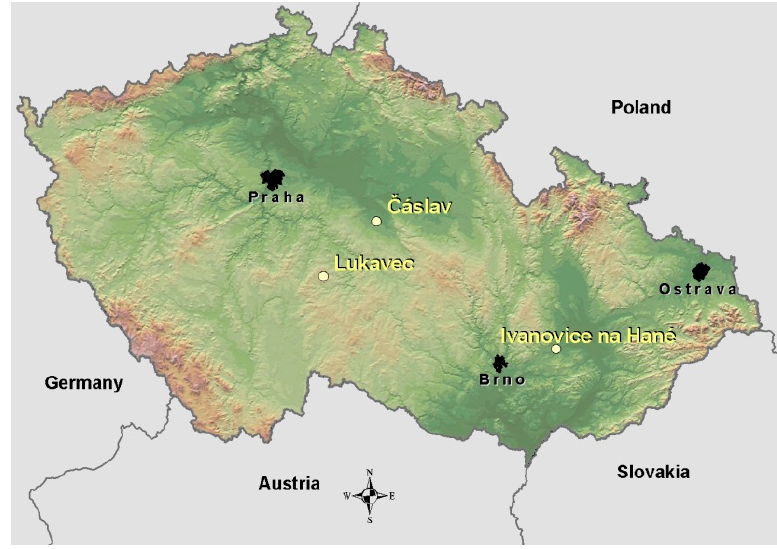
Figure 1. Map of the locations of the long-term experiments in the Czech Republic.